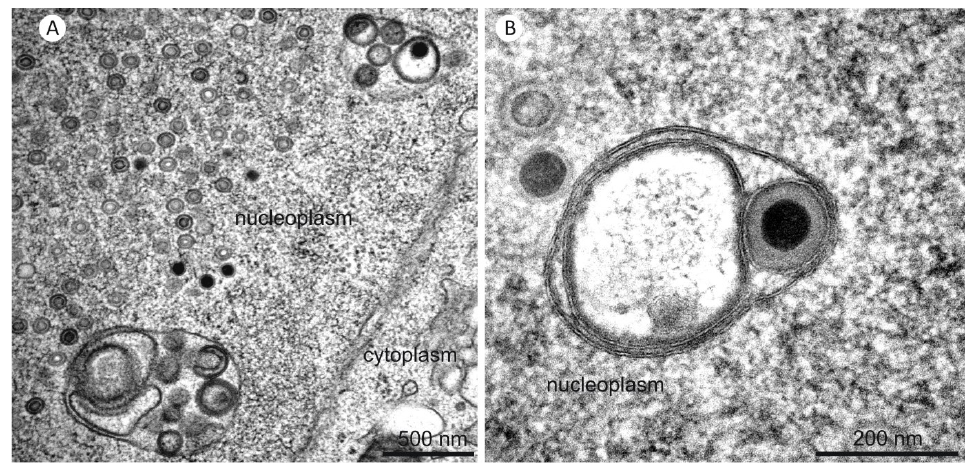
Figure 8. TEM images of nuclear infoldings in two HCMV infected fibroblast nuclei at three days post infection.